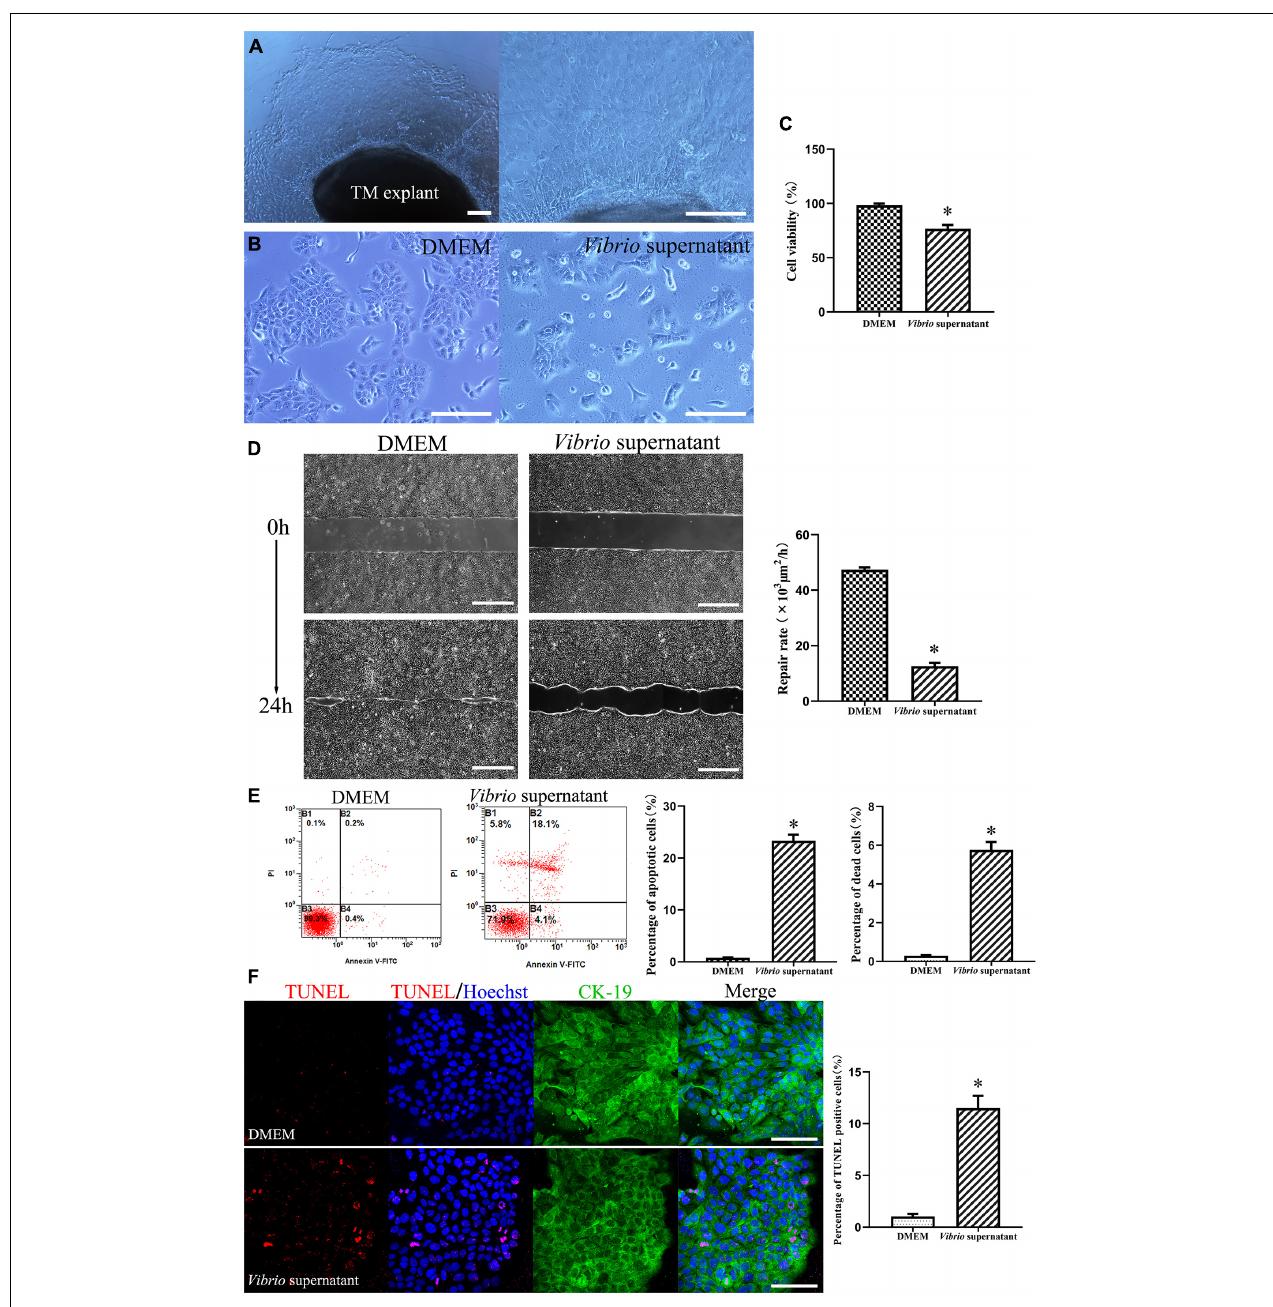
FIGURE 3 | Cytotoxic effects on tympanic membrane (TM) keratinocytes induced by Vibrio alginolyticus . The keratinocyte outgrowth from the TM explant formed a monolayer of epithelial cells, displaying a cobblestone-like morphology (A) . Cytopathic effects in keratinocytes after exposure to the V. alginolyticus culture supernatant for 24 h (B) . Quantitative analysis of cell viability measured by cell-count kit-8 (CCK-8) assay after exposure to bacterial supernatant (C) . Wound-healing migration assay was performed by analyzing repair rates of wound gaps (D) . To detect cell death and apoptosis, the proportion of apoptotic and dead cells was counted by flow cytometric analysis with Annexin V/propidium iodide (PI) double staining (E) and the number of terminal deoxynucleotidyl transferase-mediated dUTP nick-end labeling (TUNEL)-positive stained apoptotic cells was calculated (F) . The results are expressed as the mean ± standard deviation (SD) [ ∗ p < 0.05, vs. control/Dulbecco’s modified Eagle’s medium (DMEM)]. Scale bars: A, B = 200 µ m, D = 500 µ m, F = 100 µ